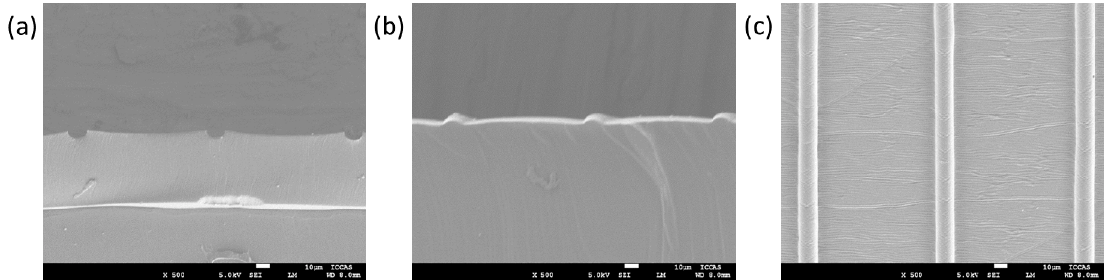
Figure 2. Morphologies of the etched template and microstructured surface, based on the etched template. ( a ) Cross-section morphology of the etched template. ( b ) Cross-section morphology of the replicated microstructure based on the etched template. ( c ) Top view morphology of the replicated microstructure based on the etched template.